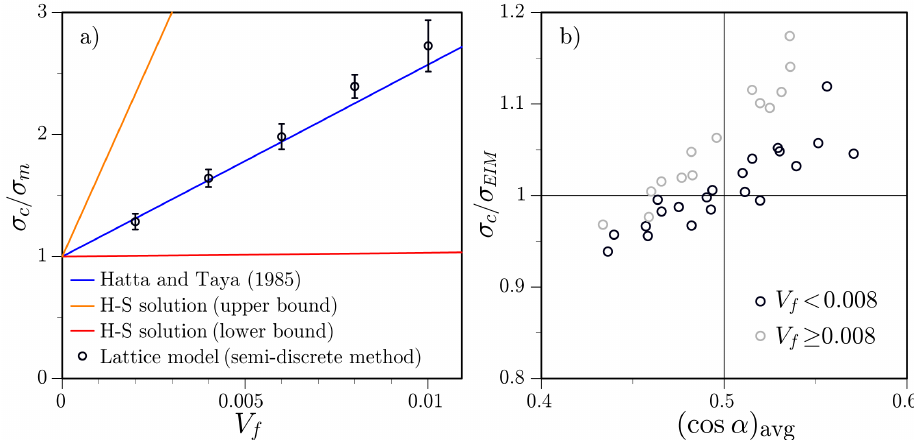
Figure 9. Relative number of nodes for discretizing the fiber composite volume.